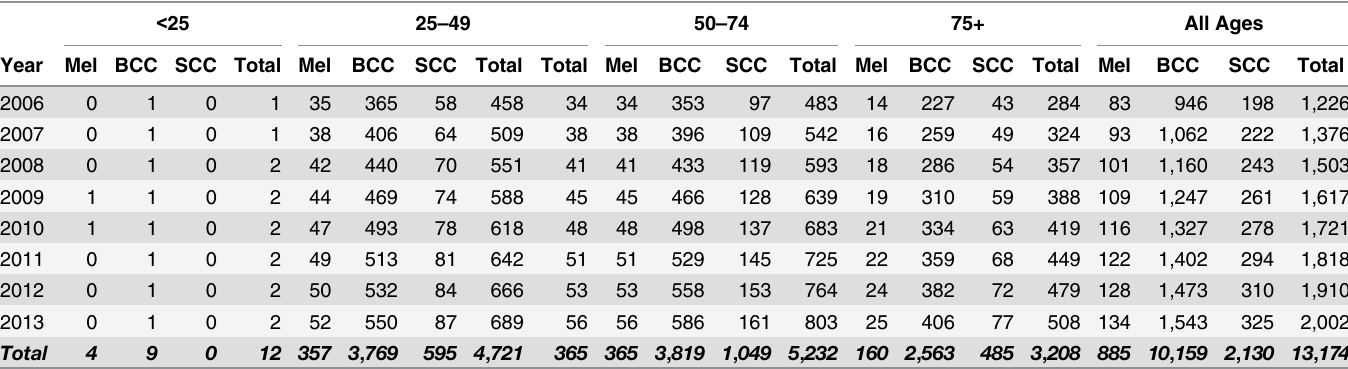
Table 2. Skin cancer cases averted, by age group, 2006 –